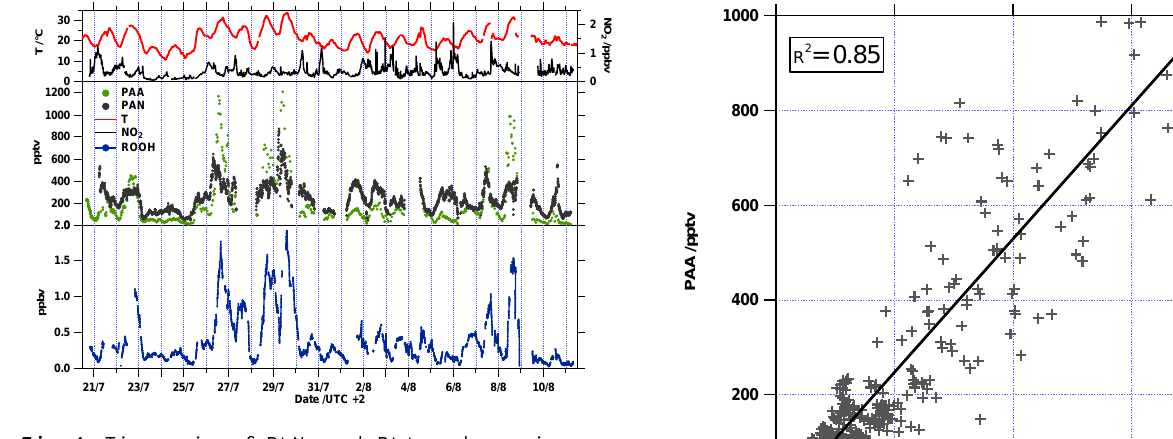
Fig. 4. Time series of PAN, and PAA and organic perox- ides (ROOH) between 21 July and 12 August 2010 during the HUMPPA-COPEC experiment along with (top panel) NO 2 mixing ratios and temperature.